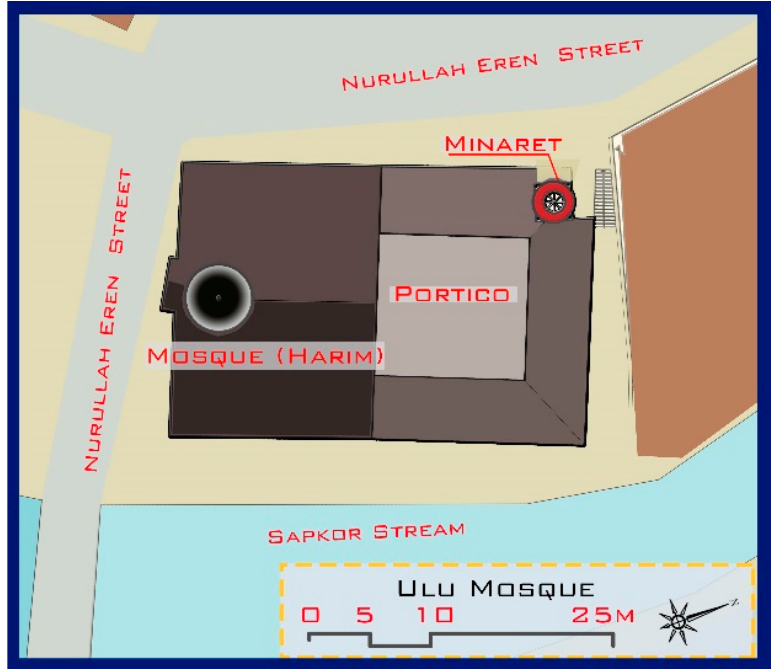
Figure 4. Bitlis Ulu (Grand) Mosque’s layout plan.